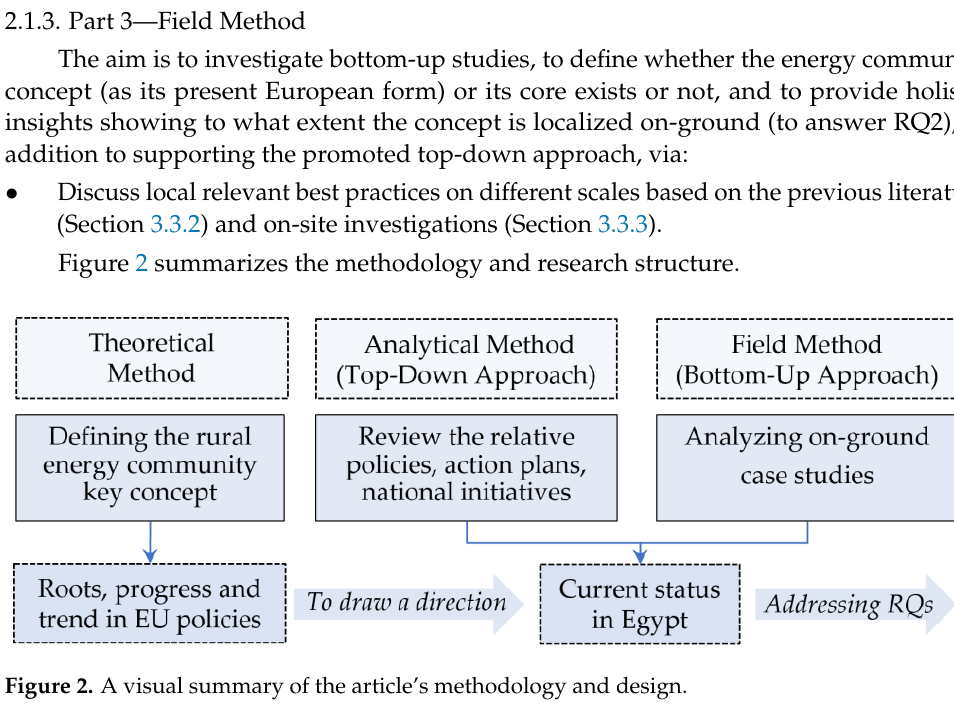
Figure 2. A visual summary of the article’s methodology and design.